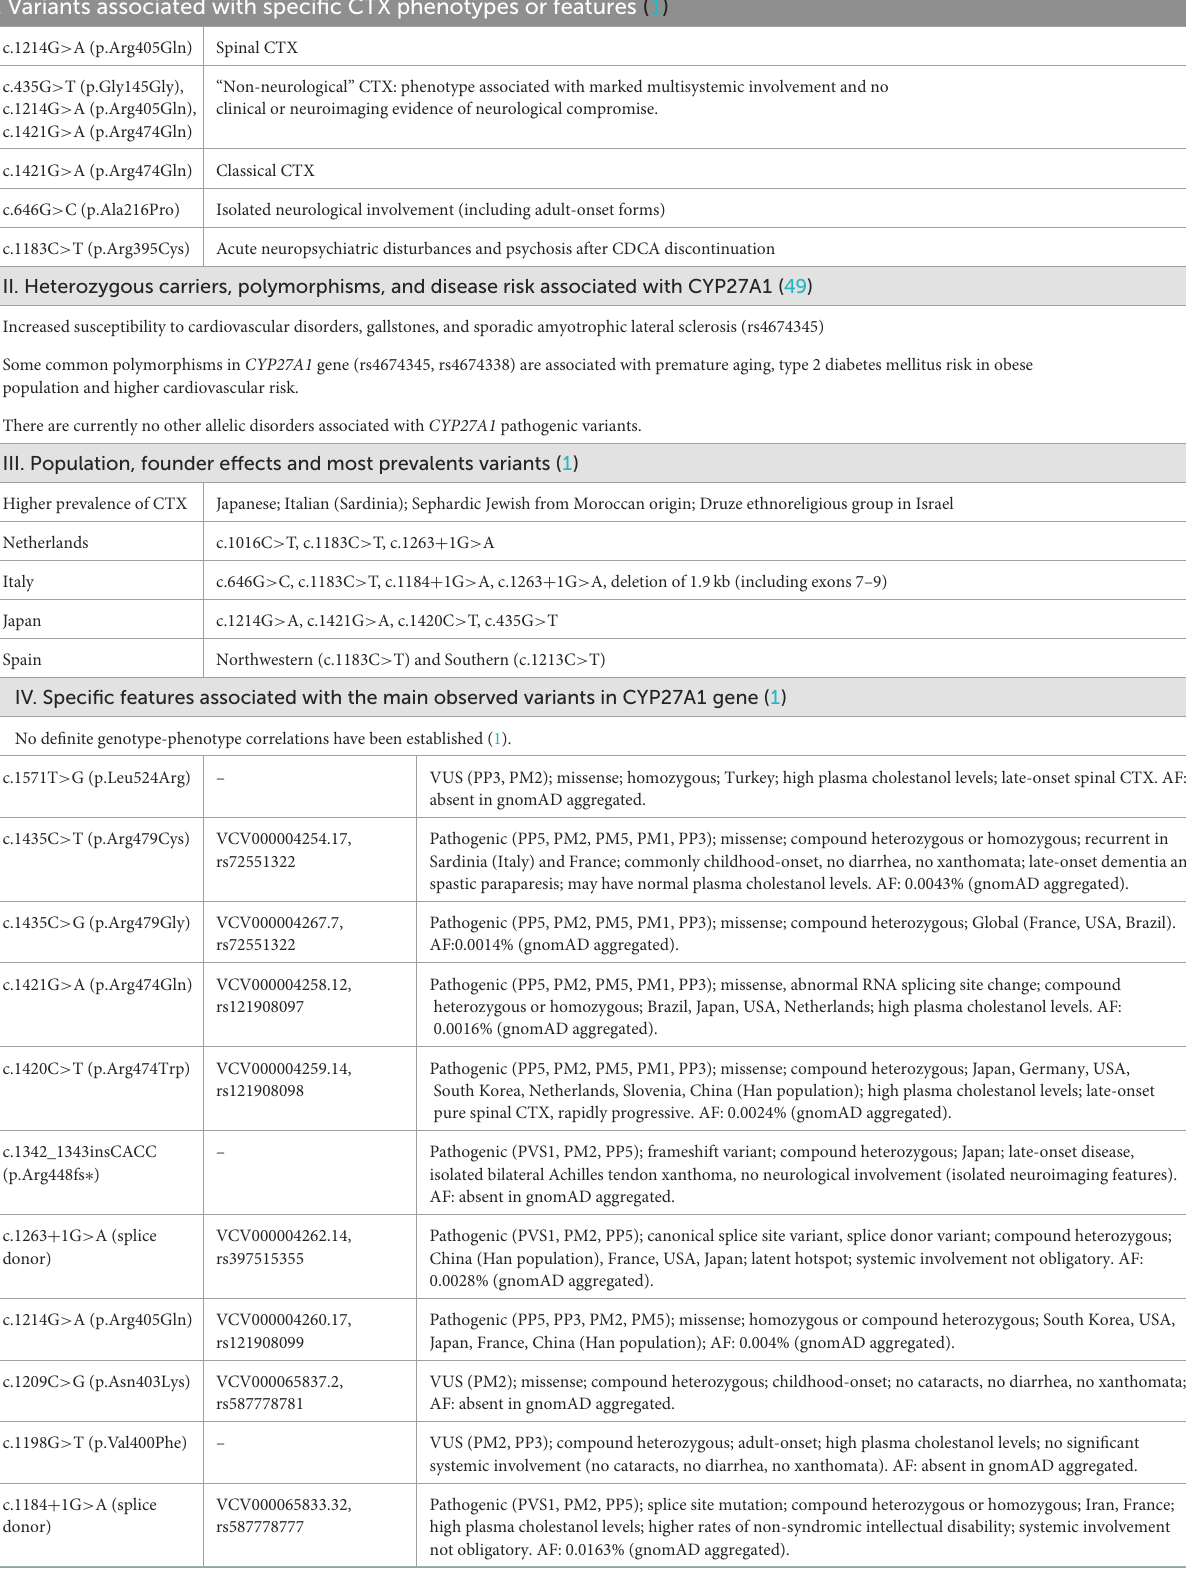
TABLE 2 Variants described in CYP27A1 gene and the main clinical and genetic correlations associated with CTX (1, 2, 4–7, 9, 17, 18, 20, 29, 48). I. Variants associated with specific CTX phenotypes or features